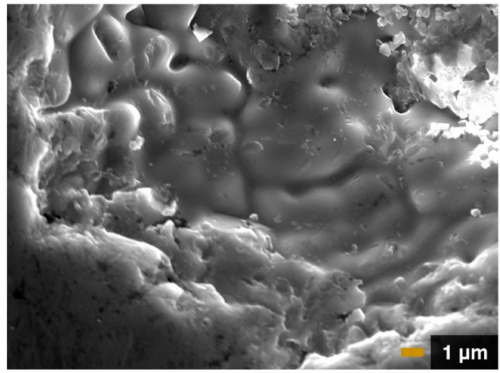
Figure 4. The fracture surface of TiAl materials prepared at a scan rate of 75 mm / s.